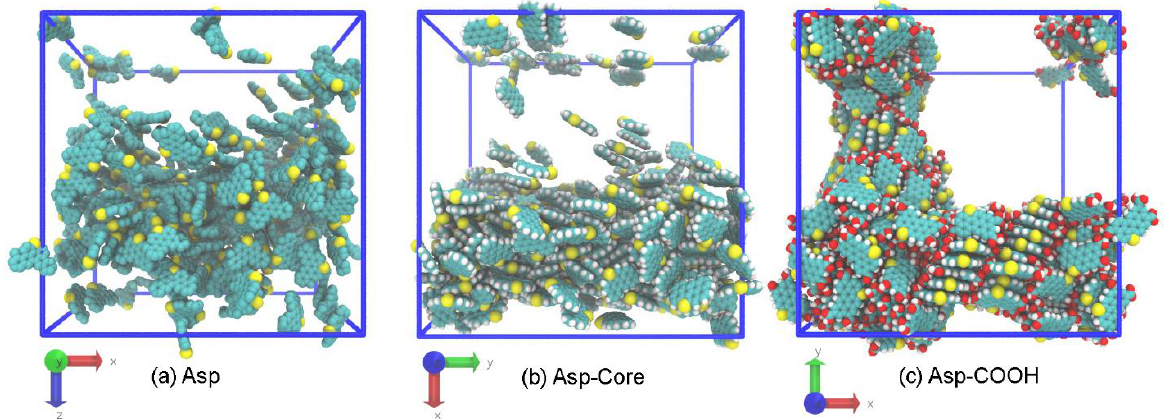
Figure 2. Typical snapshots of the asphaltene phase in the P3HT-based mixtures for the systems comprising ( a ) Asp, ( b ) Asp-Core and ( c ) Asp-COOH. In all snapshots, only polyaromatic cores are shown for clarity purposes.